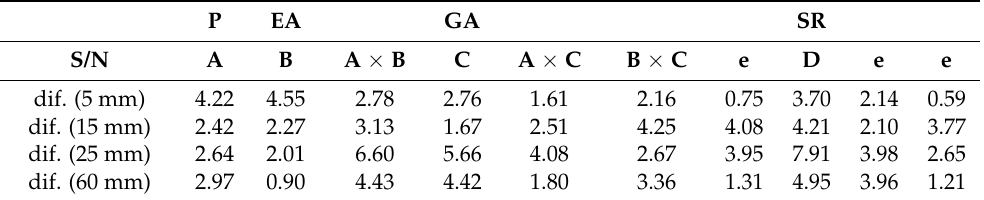
Table 8. Mean values of the S/N index and maximum differences between levels on